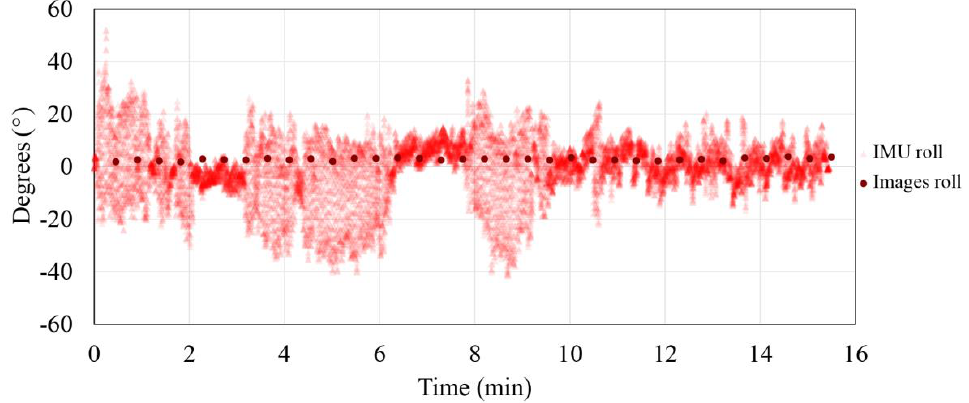
Figure 8. Exterior orientation parameters acquired photogrammetrically and by the Inertial Measurement Unit (IMU) for roll parameter.